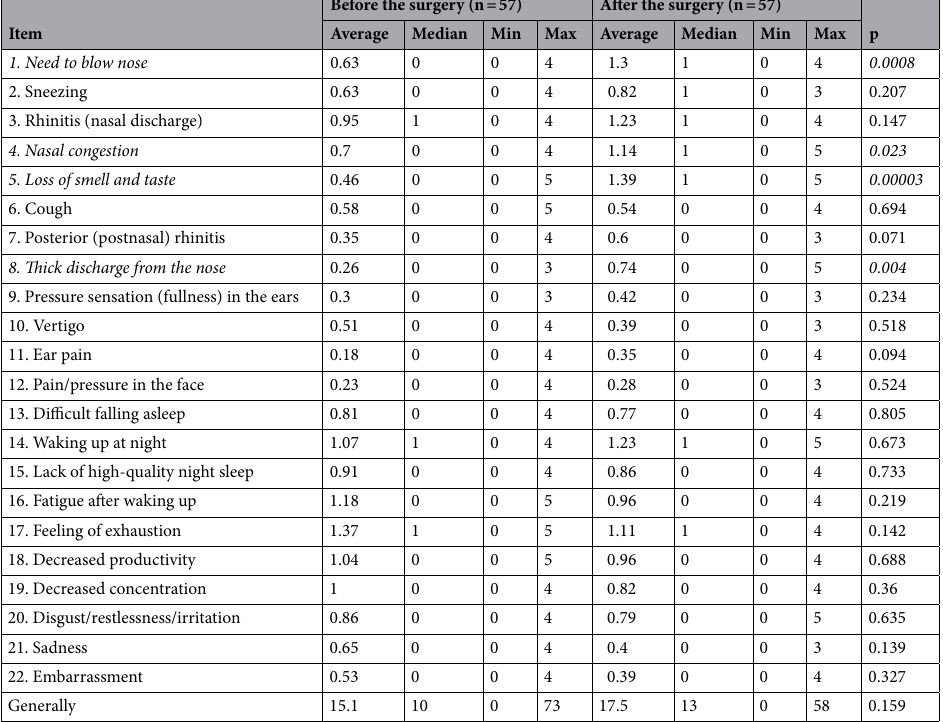
Table 3. SNOT-22 scores before the surgery and six months after the surgery in a subgroup of patients after cranial base reconstruction. Items with statistically significant change are marked in